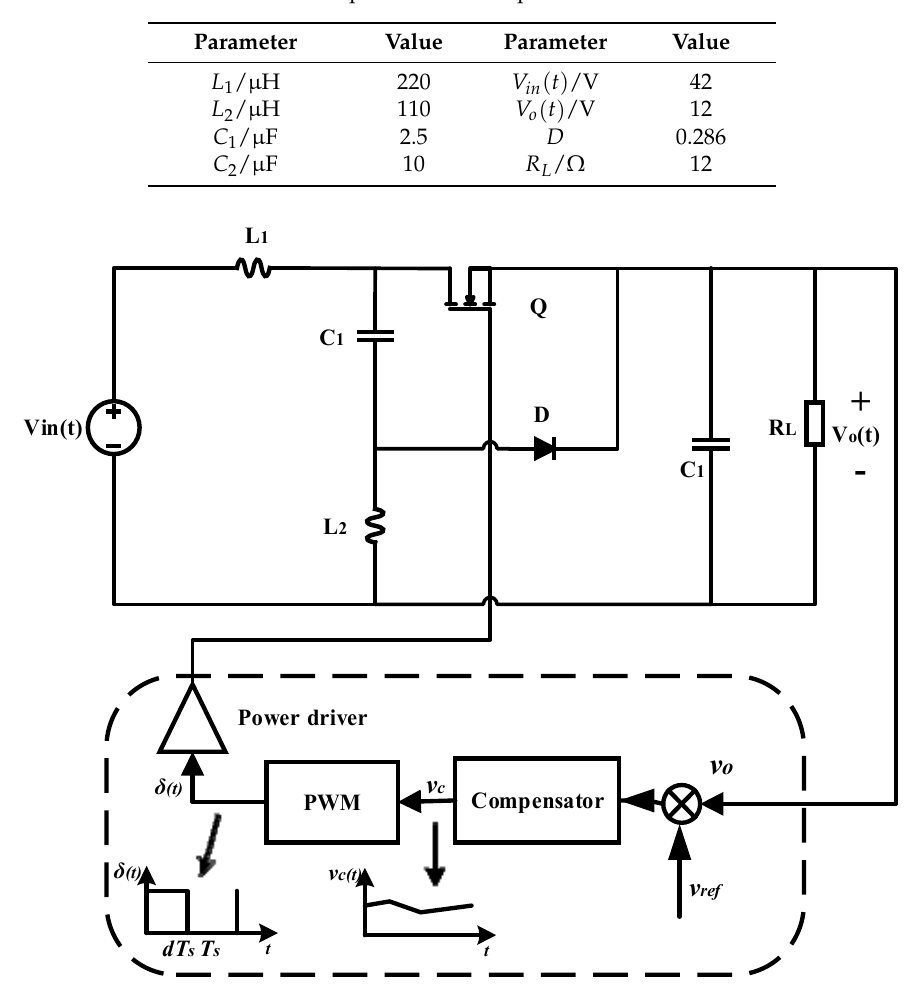
Table 1. The parameters of Superbuck converter.